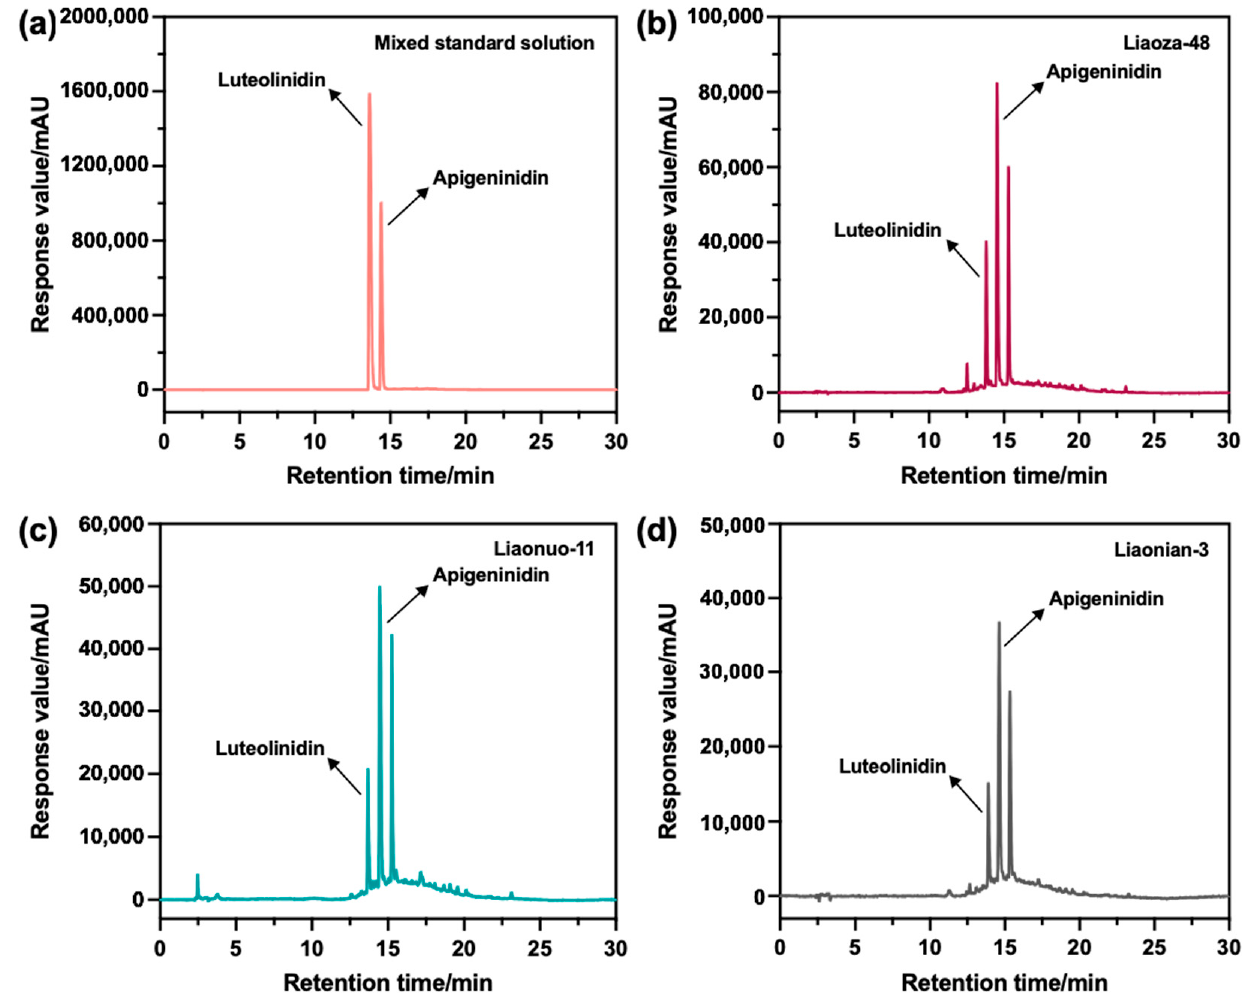
Figure 4. HPLC chromatograms of the standard Apigeninidin and Luteolinidin ( a ), as well as the extracts from different sorghum grain species (( b ): Liaoza-48; ( c ): Liaonuo-11; ( d ): Liaonian-3).